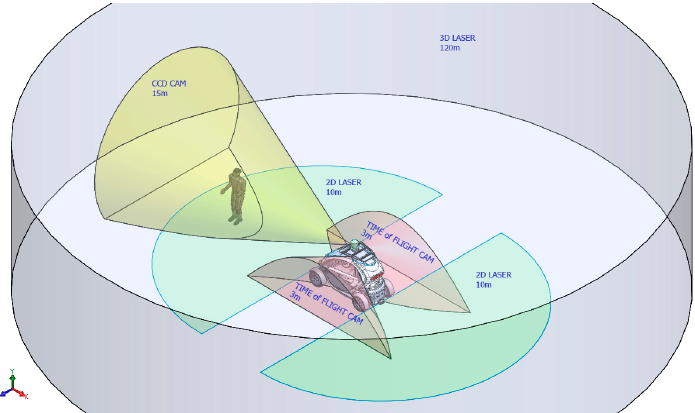
Figure 2. Range diagram of the sensors mounted on the CIC.